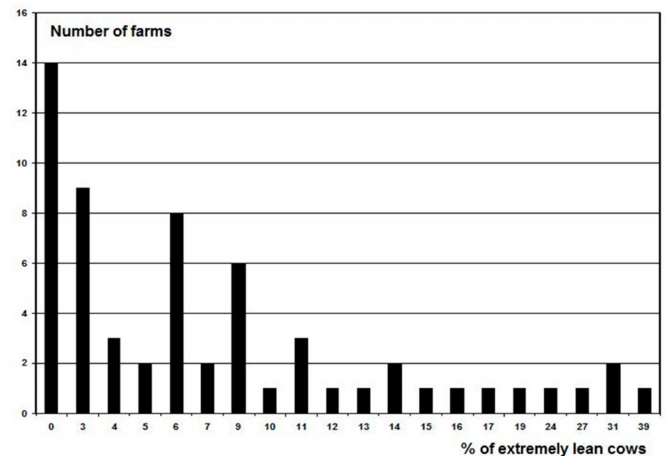
Figure 3. Frequency distribution of the percentage of extremely lean cows on the 60 farms.